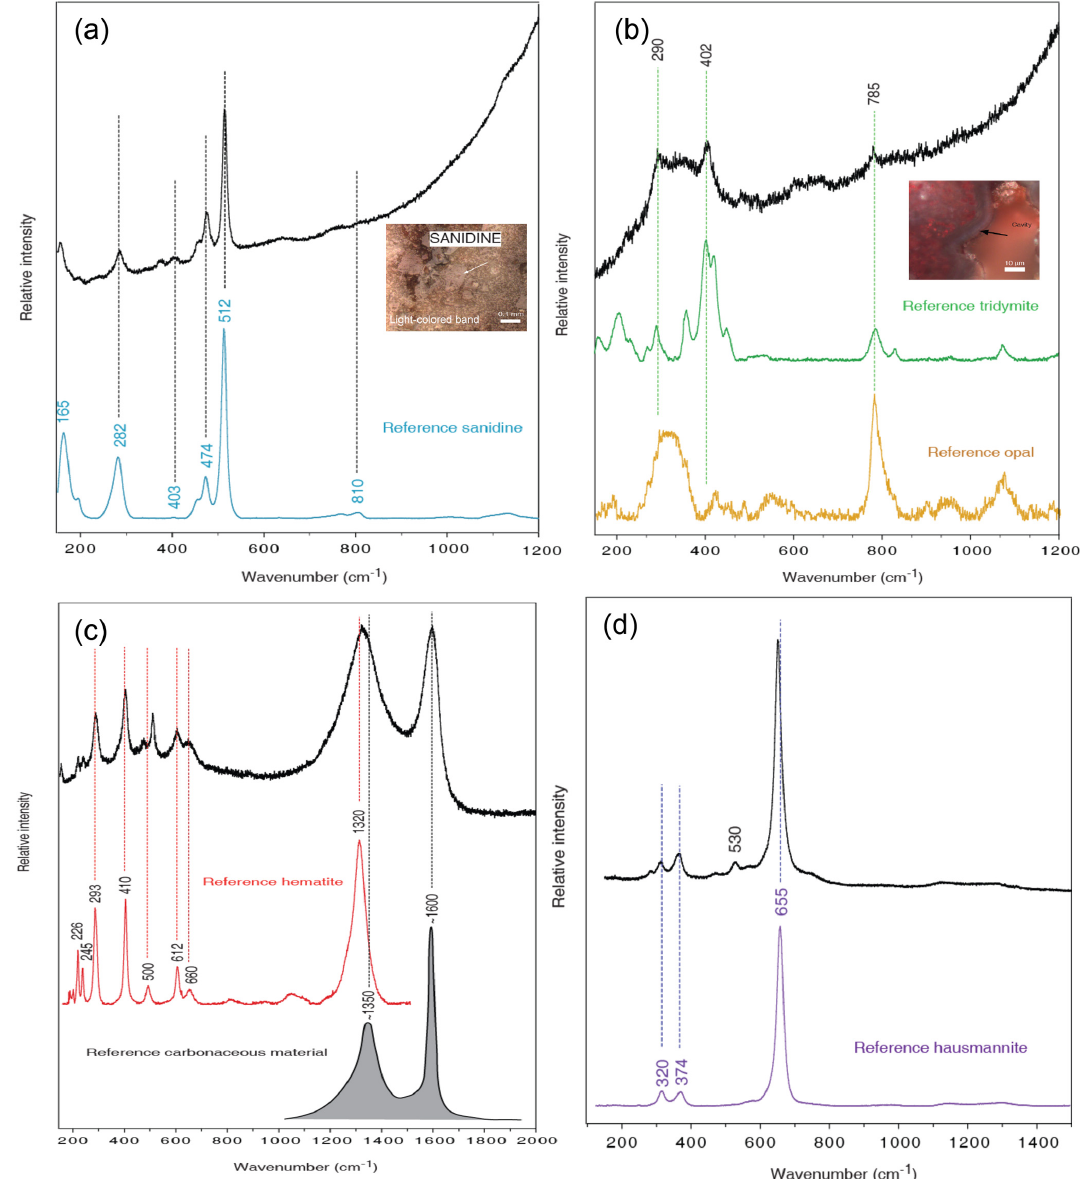
Figure 10. Raman spectroscopy of the Fe-rich and/or Si-rich bands from